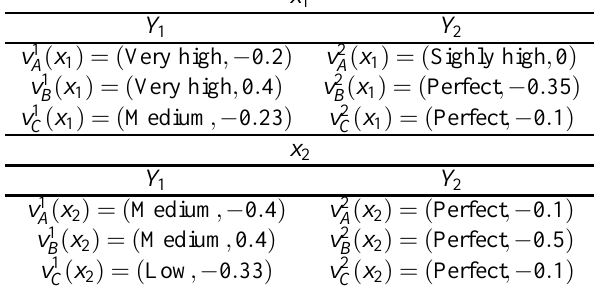
Table 5. Weighting vectors for reviewers’ collective criteria val- ues